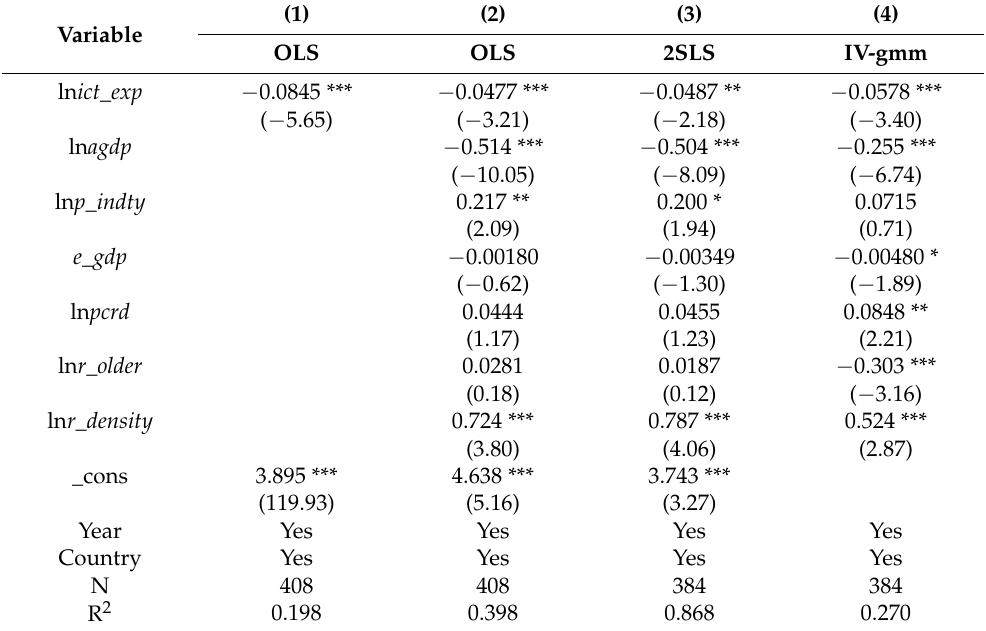
Table 4. The estimate result of the baseline